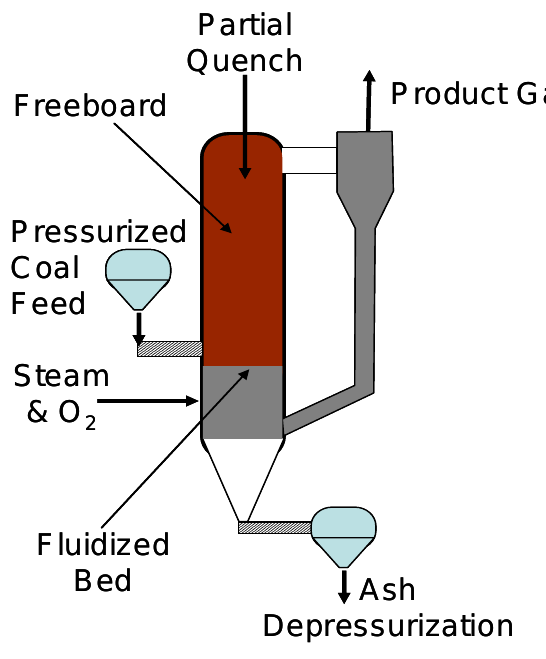
Figure 22. Fluidized Bed Gasifier